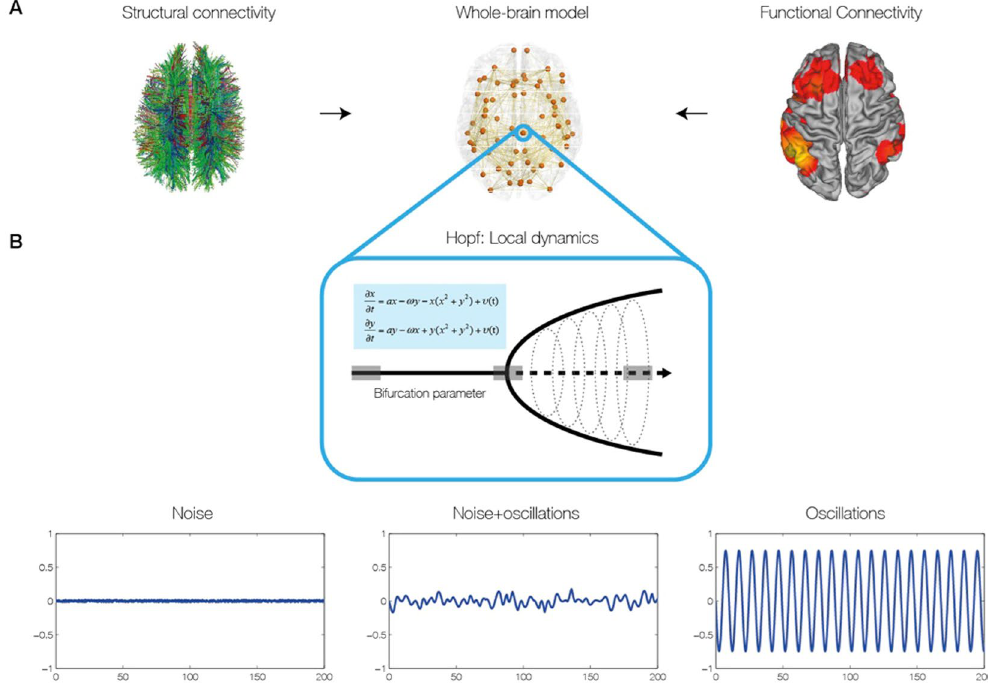
Figure 2. Construction of individual brain network models. ( A ) The brain network model was based on individual structural connectivity (SC) matrices from 24 participants derived from tractography of DTI (left) between the 68 regions of the Desikan-Kahilly parcellation (middle). The control parameters of the models were tuned using the grand average FC and FCD derived from fMRI BOLD data (right). ( B ) For modelling local neural masses we used the normal form of a Hopf bifurcation, where depending on the bifurcation parameter, the local model generates a noisy signal (left), a mixed noisy and oscillatory signal (middle) or an oscillatory signal (right). It is at the border between noisy and oscillatory behaviour (middle), where the simulated signal looks like the empirical data, i.e. like noise with an oscillatory component around 0.05